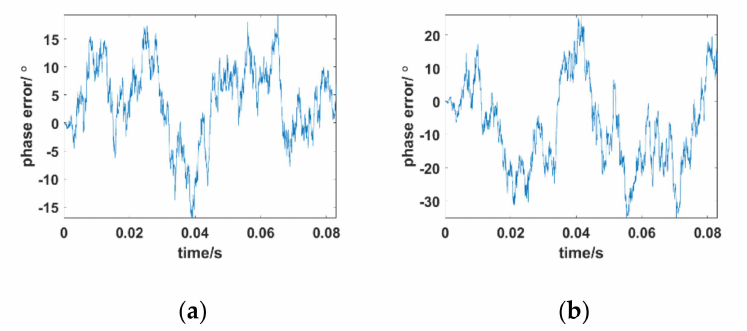
Figure 6. Phase error between the received signal and local carrier of designed Kalman tracking loop at 30 km with λ = 10 10 . ( a ) C band = 5.8 GHz; ( b ) S band = 2.3 GHz.